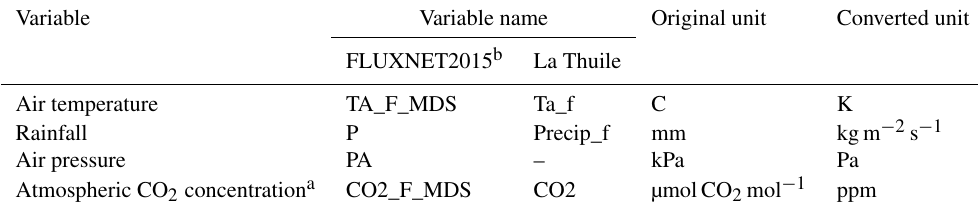
Table 4. Available unit